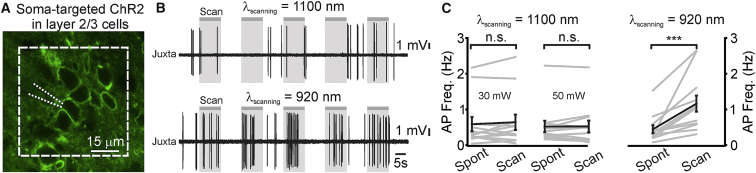
Scanning with Infrared-Shifted Wavelengths Does Not Modify the Activity of Cells Expressing Blue Light-Sensitive Opsins(A) Two-photon image of layer 2/3 cells expressing the soma-targeted ChR2-eYFP (green) in vivo. One ChR2+ neuron was recorded with a glass pipette (dotted white lines) while two-photon raster scanning inside the indicated area (dashed white line) was performed at 11 Hz.(B) Traces recorded in the juxtasomal configuration from one soma-targeted ChR2-expressing neuron during epochs (gray bars) of two-photon raster scanning at wavelength 1,100 nm (top) and wavelength 920 nm (bottom). Laser power: 30 mW in both conditions.(C) Average AP frequency during epochs of spontaneous activity (Spont) and during raster scanning (Scan). Left: results when scanning was performed at λ = 1,100 nm (laser power: 30 and 50 mW). Right: results when scanning was done at λ = 920 nm (laser power: 30 mW). Frame rate: 11 Hz; scanned area: ∼60 × 60 μm2 for all experimental conditions. p = 0.47 for λ = 1,100 nm and 30 mW, p = 0.85 for λ = 1,100 nm and 50 mW, p = 5E−4 for λ = 920 nm and 30 mW, Wilcoxon signed rank test, N = 12 FOVs from 3 mice.In this figure, the black line represents the average and SEM, individual experiments are depicted in gray.